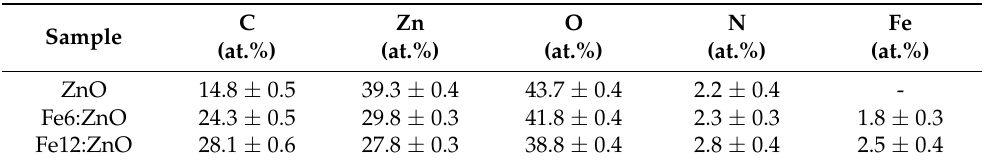
Table 2. Relative atomic concentration for ZnO and Fe:ZnO nanoparticles estimated from HR-XPS analysis.